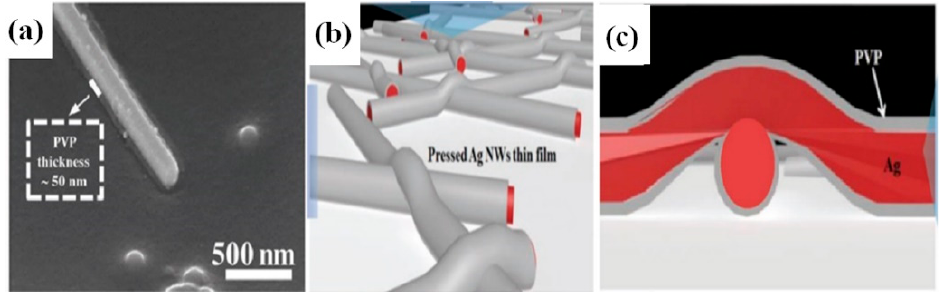
Figure 16. ( a ) SEM images of AgNWs surrounded by PVP layer of ~50 nm thickness ( b , c ) the con- cept of treatment for sheet resistance reduction (adapted from [188] with permission from John and Wiley sons, 2018) sons,